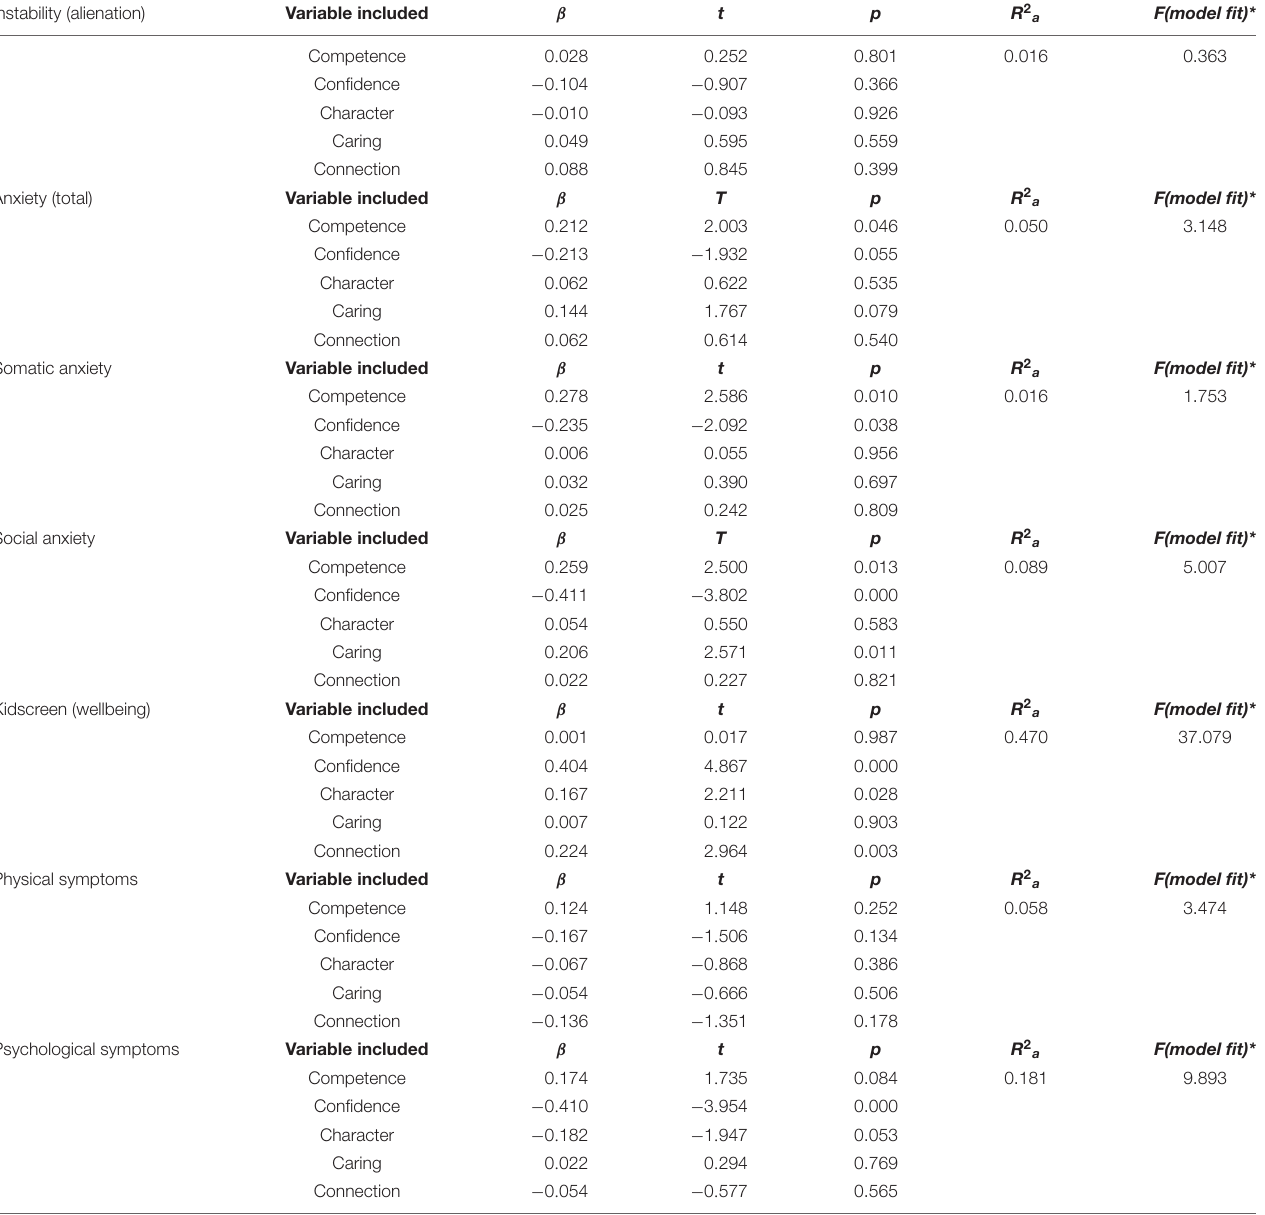
TABLE 3 | Multiple linear